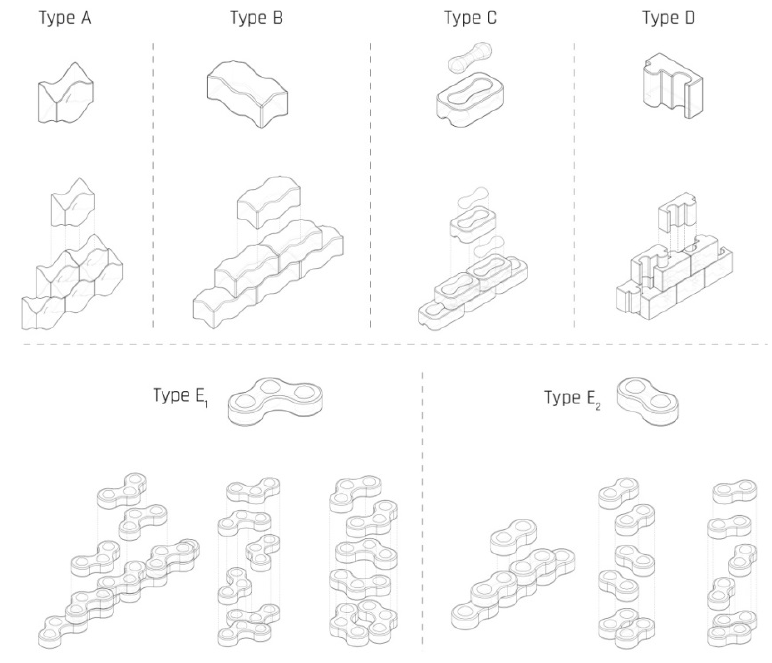
Fig. 3: Developed interlocking